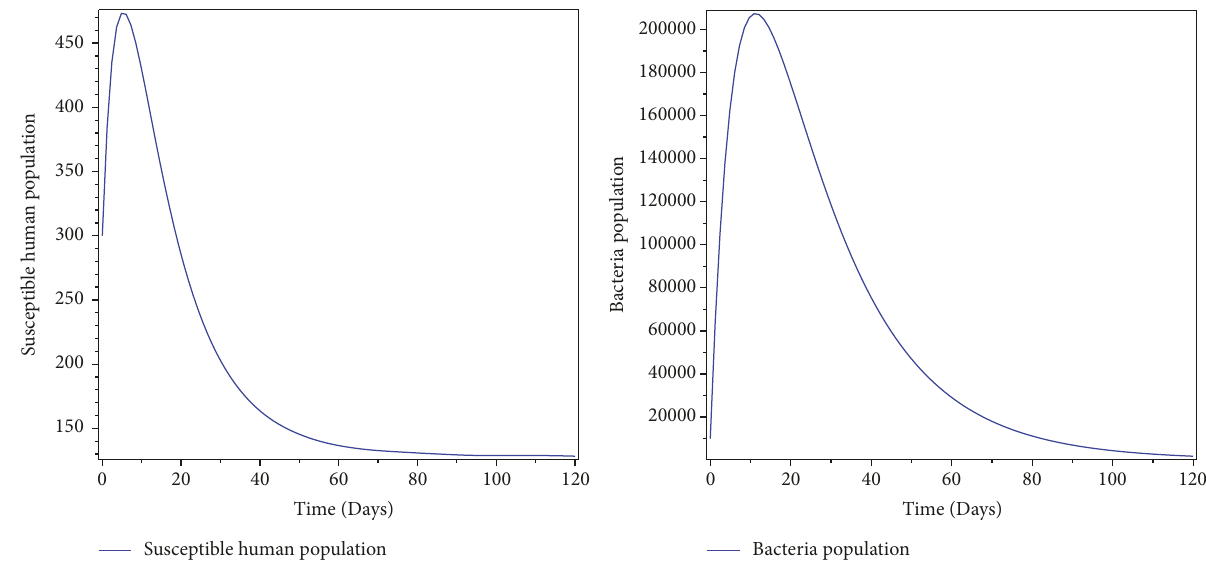
Figure 8: Simulation of model showing susceptible human and bacteria